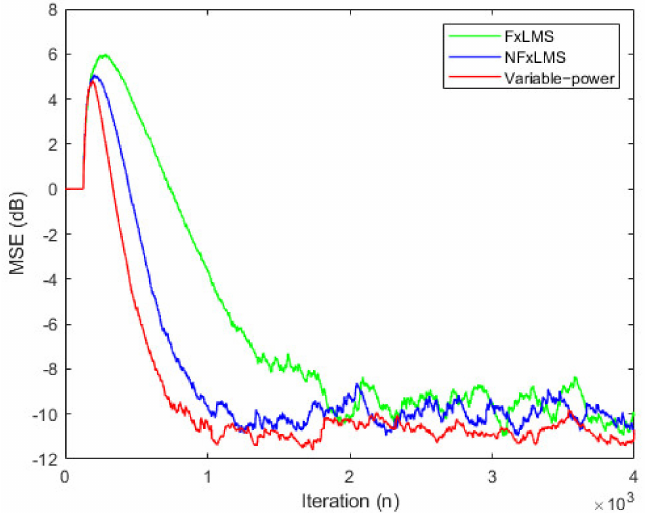
Figure 2. Performance comparison. The horizontal axis is iteration (n) and the vertical axis is MSE (dB). Legend is FxLMS, NFxLMS, and variable-power,